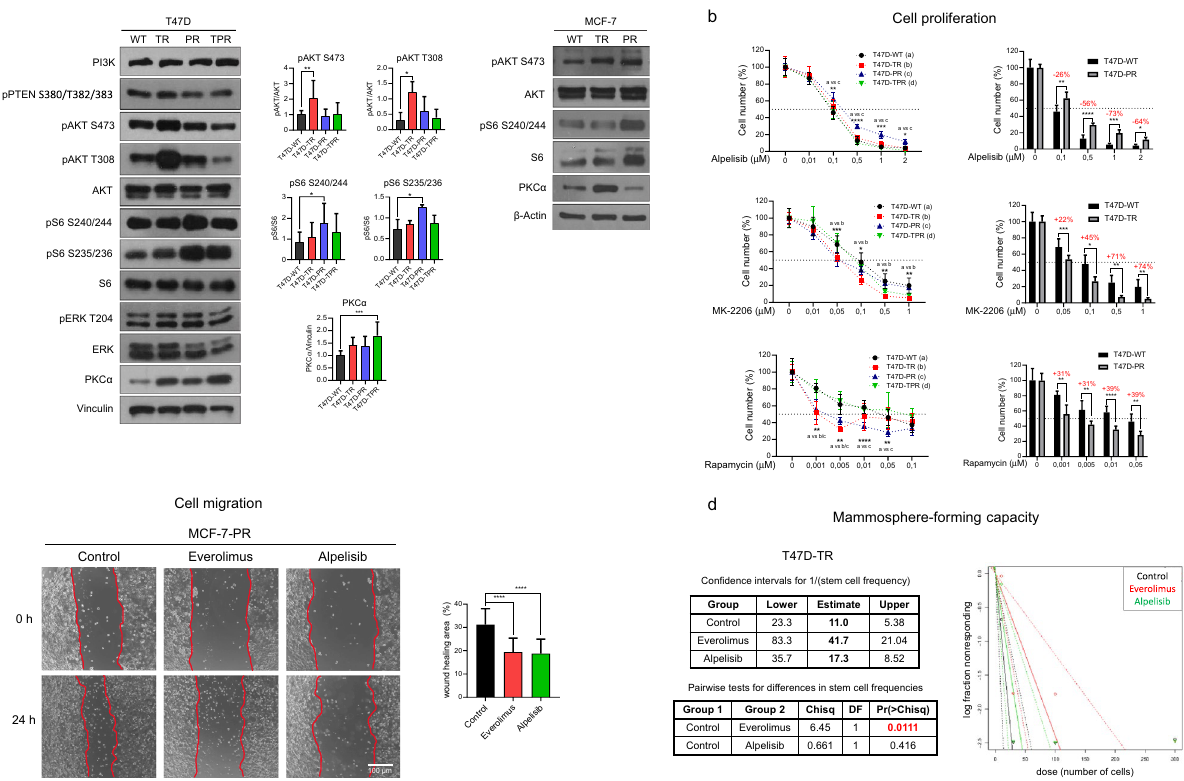
Figure 3. Targeting PI3K/AKT/mTOR pathway in the resistant cells. ( a ) Activation of PI3K/AKT/mTOR pathway. Protein lysates were obtained under basal conditions and analyzed by immunoblot with the indicated antibodies. For T47D variants, bands were quantified by densitometry and relativized to their loading control. *p < 0.05, **p < 0.01, ***p < 0.001. Data represent mean ± SD, one-way ANOVA followed by Dunnett’s test (independent replicates n = 3, with 3 experimental replicates in each group). ( b ) Effect of PI3K/AKT/ mTOR inhibitors on cell proliferation. Cells were treated with increasing concentrations of alpelisib (PI3Kα inhibitor), MK-2206 (pan-AKT inhibitor) and rapamycin (mTORC1 inhibitor) for 7 days and counted at the end of the experiment. Bar graphs on the right show the percentage (red numbers) of increase (+) or decrease (−) in inhibition of cell proliferation at the different concentrations. *p < 0.05, **p < 0.01, ***p < 0.001, ****p < 0.0001. Data represent mean ± SD at each drug concentration, two-way ANOVA followed by Dunnett’s test (independent replicates n = 2, with 4 experimental replicates in each group). ( c ) Effect of PI3K/AKT/mTOR inhibitors on cell migration. Wound healing assays were performed in MCF-7-PR cells. Cells were treated with alpelisib (0.1 µM), everolimus (0.1 µM) or vehicle for 24 h. Representative pictures at the beginning (T0) and at the end (Tf) are shown on the left panel. The wound healing area was quantified as T0-Tf (right). ****p < 0.0001. Data represent mean ± SD, one-way ANOVA followed by Dunnett’s test (independent replicates n = 2, with 4 experimental replicates in each group). ( d ) Effect of PI3K/AKT/mTOR inhibitors on mammosphere-forming capacity. Extreme limiting dilution assays were performed in T47D-TR cells. Cells were treated with alpelisib (0.1 µM), everolimus (0.1 µM) or vehicle for 7 days. Left: Sphere formation frequencies were compared using the ELDA web tool. Right: The number of cells seeded per well versus the logarithmic fraction of wells without any detected spheres was plotted. Trend lines represent the estimated active cell frequency, dotted lines show the 95% confidence interval. P-values for significant differences between treatments were calculated using ELDA webtool software (independent replicates n = 2, with 6 experimental replicates in each group). Original blots/gels are presented in Supplementary Material, unprocessed western blots section. Original images are presented in Supplementary Material, unprocessed photomicrographs